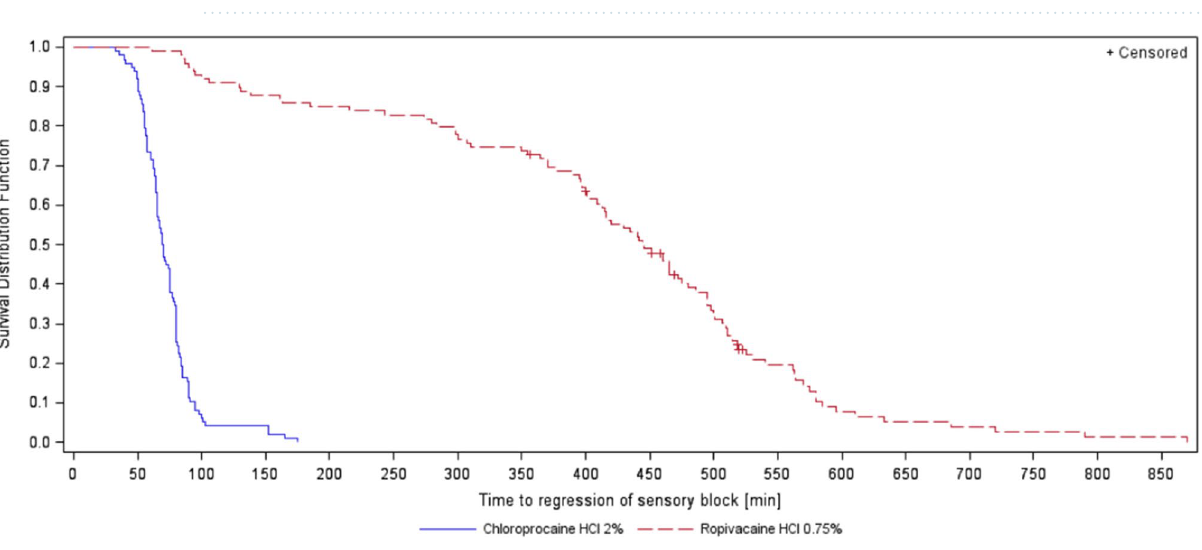
Figure 2. Time to regression of motor block (min).